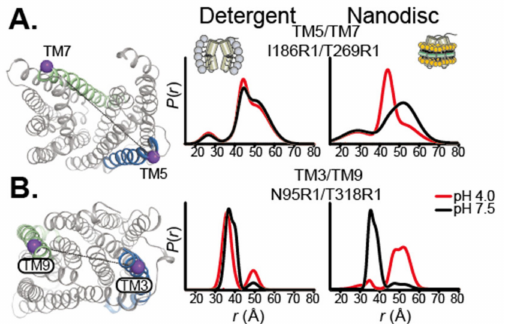
Figure 3. Ligand-dependent conformational dynamics of PfMATE require a lipid environment. ( A ) Representative spin label pair sampling distances between TM5 and TM7 on the extracellular side and ( B ) TM3 and TM9 on the intracellular side of PfMATE. The spin label locations are highlighted on the OF structure by purple spheres connected by a line. The helices targeted in the N-lobe and C-lobe are highlighted in blue and green, respectively. Distance distributions, representing the probability of a distance P(r) versus the distance (r) between spin labels, are shown in black traces at pH 7.5 and red traces at pH 4.0 in DDM micelles ( left ) and lipid nanodiscs ( right ). Adapted with permission from